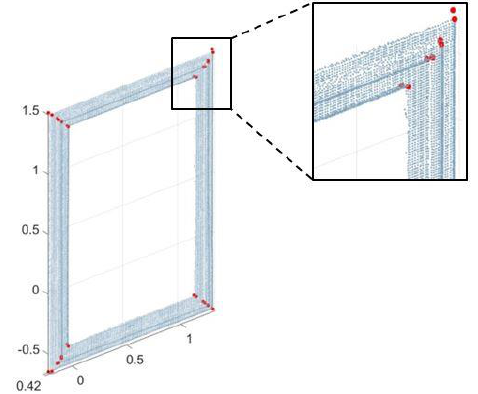
Figure 12. Characteristic points (in red) belonging to frame edges and projected on the corners of the frame